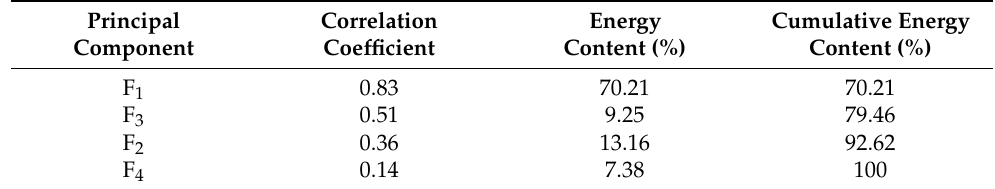
Table 2. Correlation coefficients of four principal components and the sand thickness, energy content, and cumulative energy